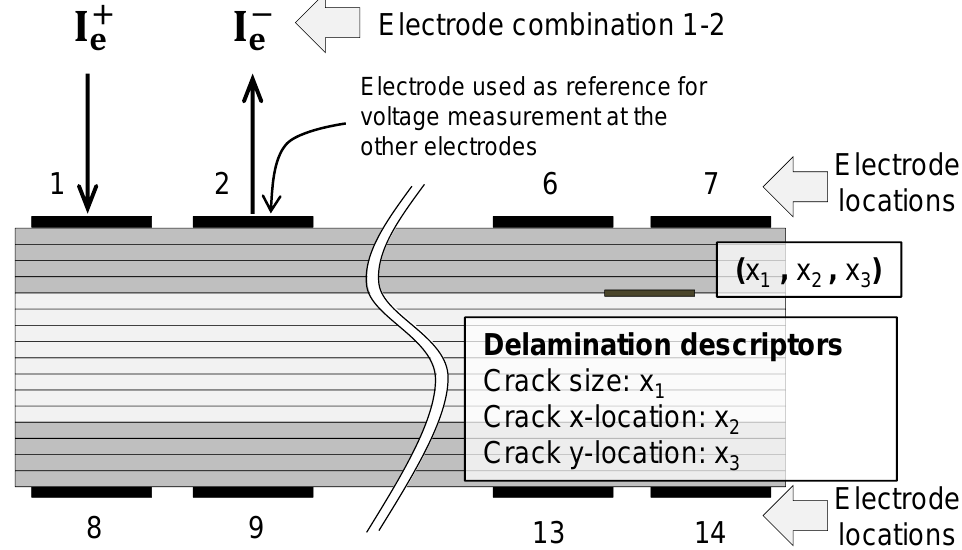
Figure 1. Schematic representation of a [ 0 4 /90 4 ] s composite laminate under damage with 14 electrodes where electric current is injected in pair